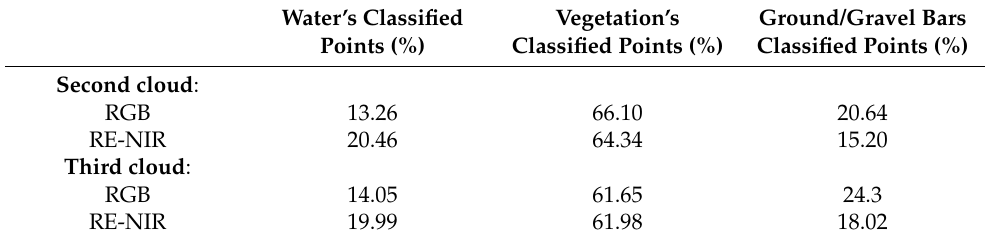
Table 7. Percentages related on RGB and RE+NIR classifications processing.